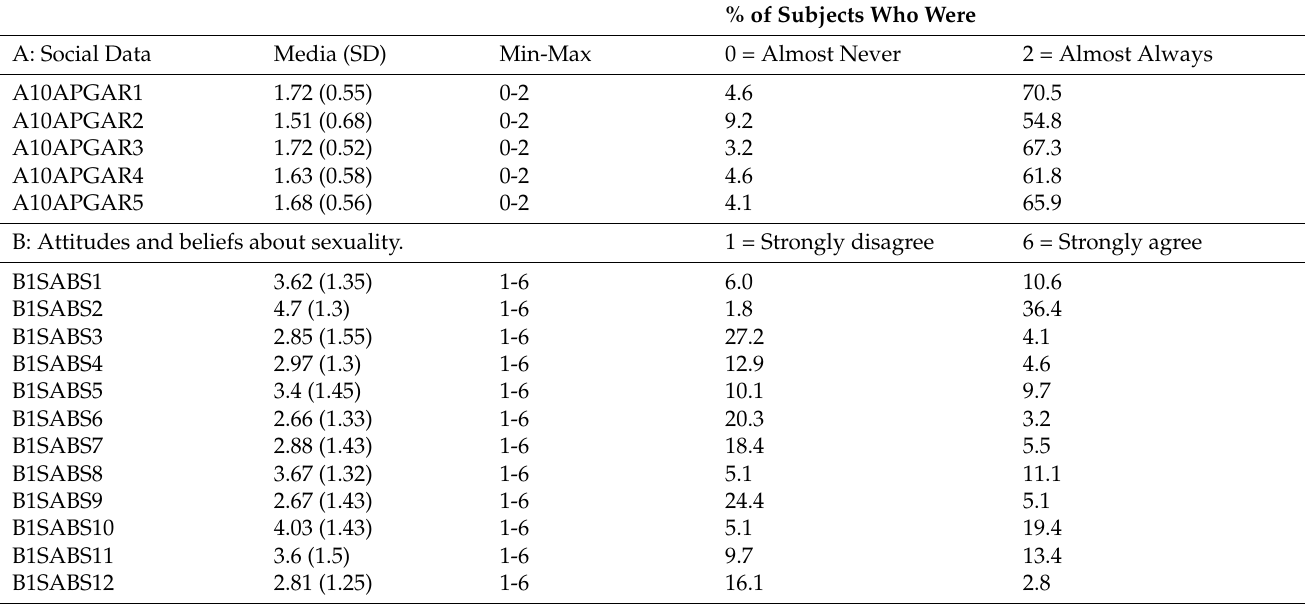
Table 4. Descriptive statistics of SABS